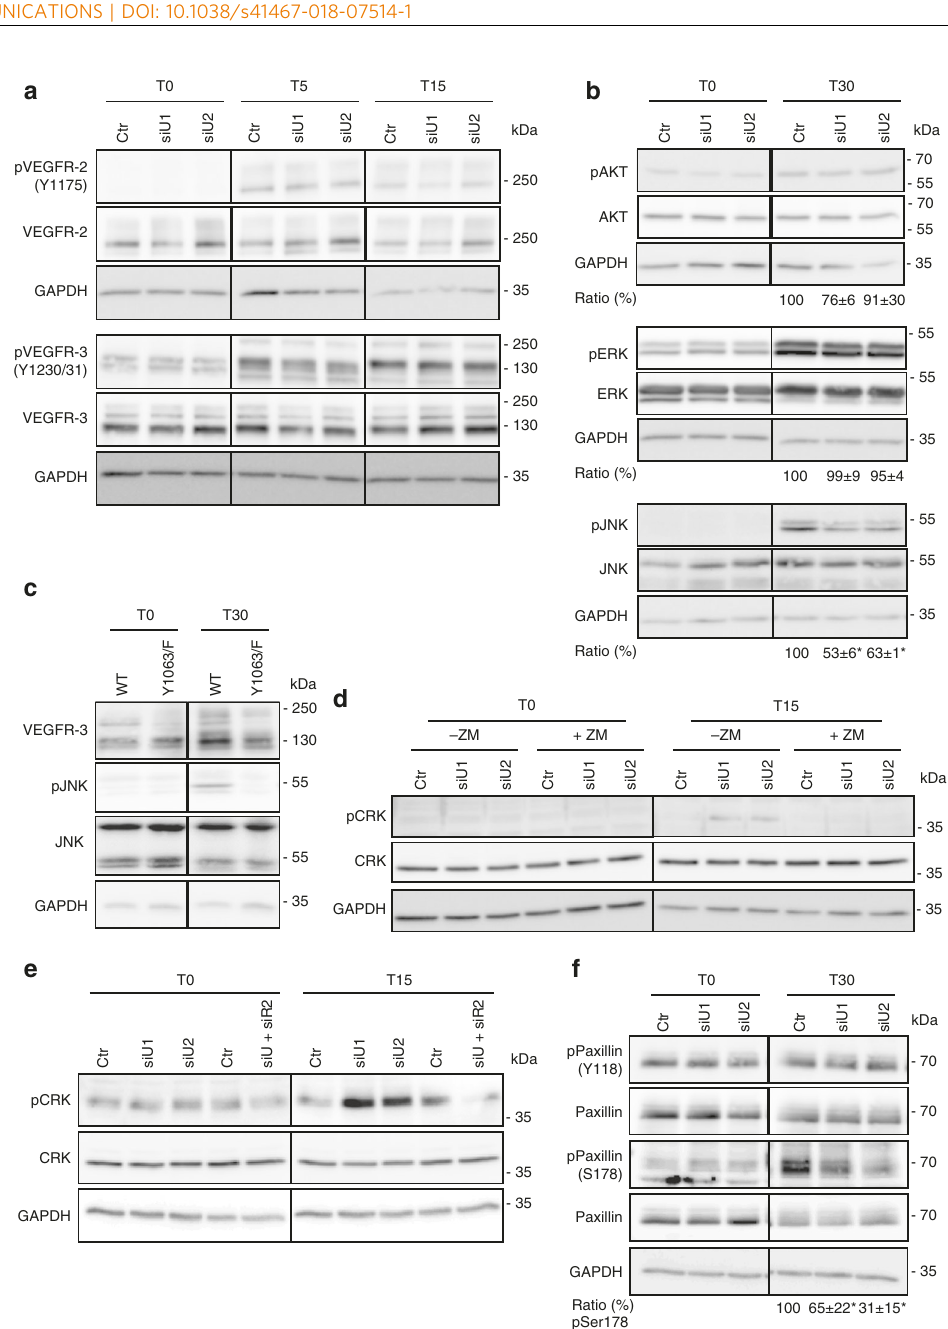
Fig. 6 uPARAP downregulation impairs the Crk/JNK/paxillin pathway. a , b , d – f LECs were treated with siRNAs targeting uPARAP (siU1 and siU2) or a control siRNA (Ctr) and stimulated for the indicated time (minutes) with VEGF-C. a – f Western blot of total and phosphorylated (p) VEGFR-2 (Y1175), VEGFR-3 (Y1230/31) ( a ), ERK, AKT, JNK ( b , c ), Crk ( d, e ) and Paxillin (Y118, S178) ( f ). c PAECs expressing uPARAP were transfected with a plasmid carrying an intact (WT) or mutated (VEGFR-3 Y1063/F ) VEGFR-3 cDNA. JNK phosphorylation was evaluated by Western blot after VEGF-C stimulation. d , e LECs were treated ( + ZM) or not (-ZM) with VEGFR-2 inhibitor (ZM323881), or siRNA against VEGFR-2 (siR2). For quanti fi cation of Western blot band densities, values were calculated as the ratio of phosphorylated to total form and normalised to the values obtained with the control (Ctr) ( n = 3, biological replicates). Statistical analyses were performed using a non-parametric Mann – Whitney test. * P < 0.05 Mice . uPARAP − / − or + / + FVB/N mice 44 (8 to 10-week-old) were used room temperature for 1h and then blocked with 3% milk, 3% BSA for 1h at room throughout this study, except for tail preparation conducted during the fi rst post- temperature. Corneas were then incubated with a polyclonal goat anti-mouse natal week (at P6). The animals were maintained under a 12-h light-dark cycle with lymphatic vessel endothelial receptor-1 (1/200; AF2125, R&D Systems) antibody free access to food and water. Animal experiments were performed in compliance overnight at 4°C. After washing in PBS, an alexa Fluor 488-coupled rabbit anti- with the Animal Ethical rules of the University of Liège (Liège, Belgium) after goat antibody (1/200; A21222, Invitrogen) 47 was added for 2 h at room tempera- approval of the local Animal Ethical Committee. ture. Double immunostainings with LYVE-1 (1/200; R&D Systems) and CD11b (1/ 250; 557395, BD Biosciences), F4/80 (1/100; Ab 16911, Abcam) or CD31 (1/200; 553370, BD Biosciences) were performed as previously described by Detry et al. 28 The lymphangiogenic responses were analysed using a described computerised In vivo corneal assay . Corneal lymphangiogenesis was induced by thermal cau- method 28,45 . All results were normalised to the total cornea area and are expressed terisation, and corneas were whole mounted for immunostainings as previously as densities. Neovessels were isolated from cornea images, and vascular loops were described 45 – 47 . To visualise lymphatic vessels, corneas were fi xed in 70% ethanol at NATURE COMMUNICATIONS| (2018) 9:5178 |DOI: